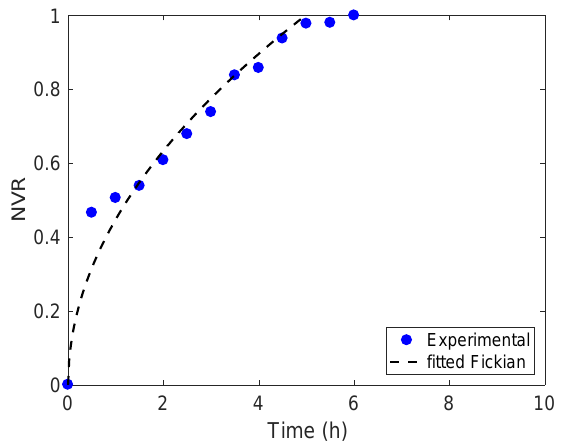
Figure 4. Predicted release curve for encapsulated riboflavin at pH 5.2 using estimated D app (dash –) compared to experimental curve (blue dots).